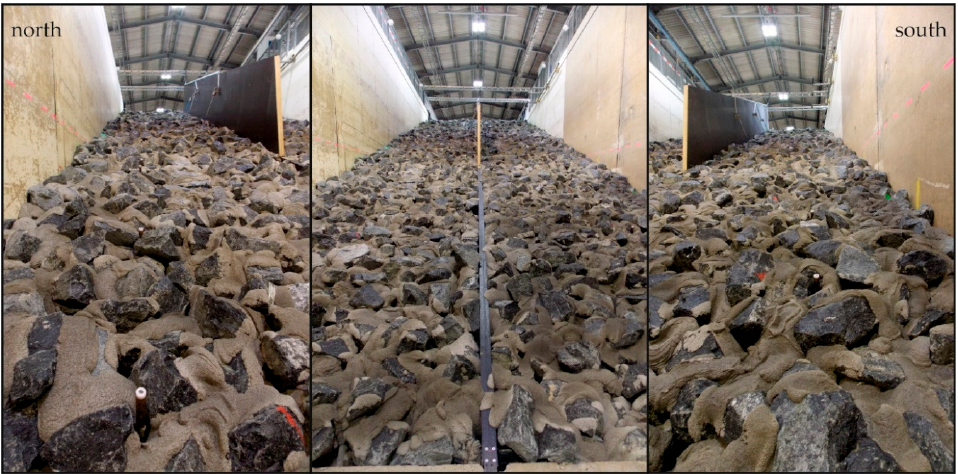
Figure 3. Partially grouted MGRRs ( v g = 80 L/m²) in test phase one (Photos: Kreyenschulte and Kühling, 2017). Kühling,